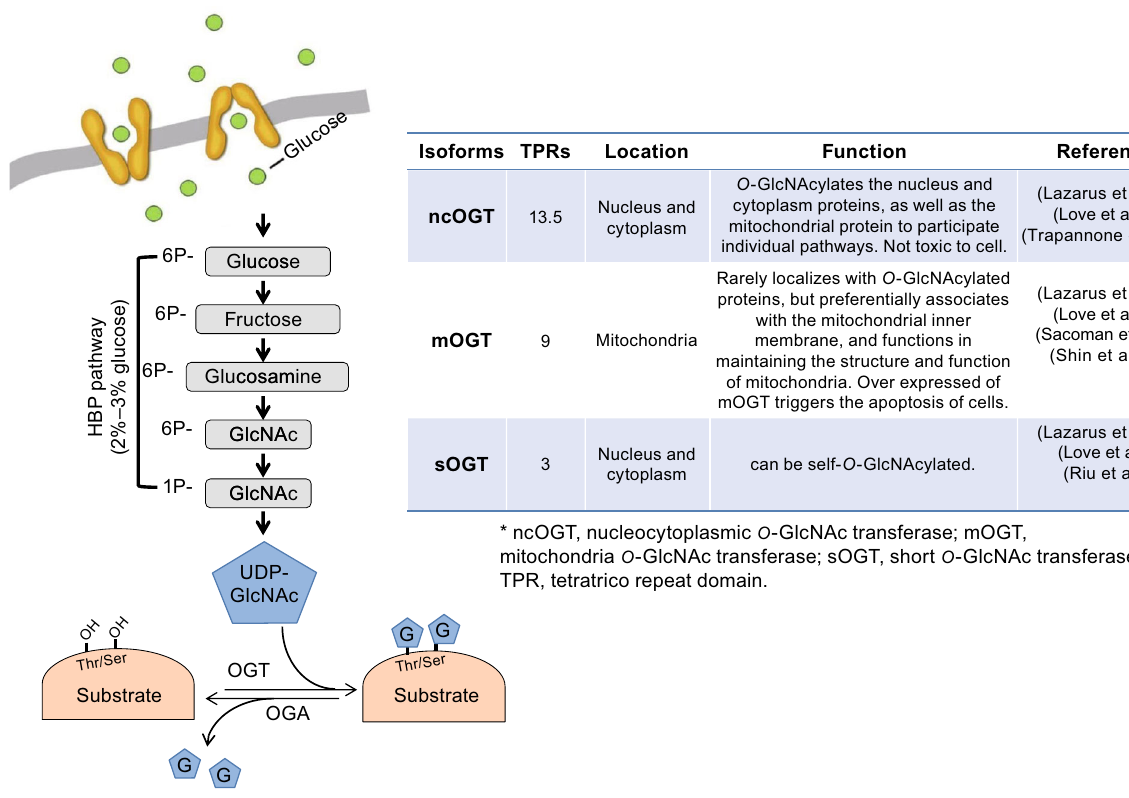
Figure 1. The process of O -GlcNAc modi fi cation and the molecular structure of OGT isoforms. A range of 2% – 3% glucose uptake by the cells goes through the HBP pathway, experiences a series of modi fi cation and synthesize UDP-GlcNAc, the substrates of O -GlcNAc reaction. OGT/OGA are the enzymes in charge of add/remove UDP-GlcNAc at Ser or Thr residues respectively to control the balance of intracellular O -GlcNAcylation level. The molecular structure of 3 isoforms of OGT is highly conserved. By alternative splicing, 3 isoforms of OGT including nucleocytoplasmic isoform (ncOGT, 116 kDa), the mitochondrial isoform (mOGT, 103 kDa), and the short isoform (sOGT, 75 kDa)